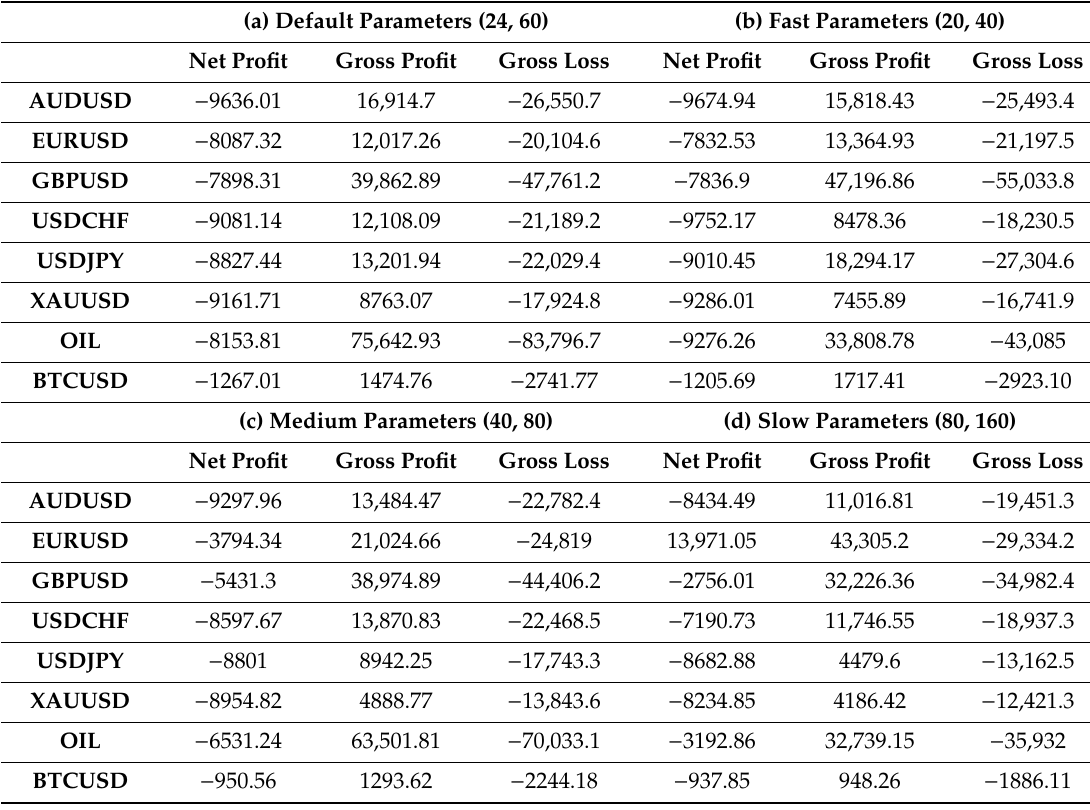
Table 2. Classic Turtle’s gross profits, gross losses and net profits for experiments (a), (b), (c) and (d).